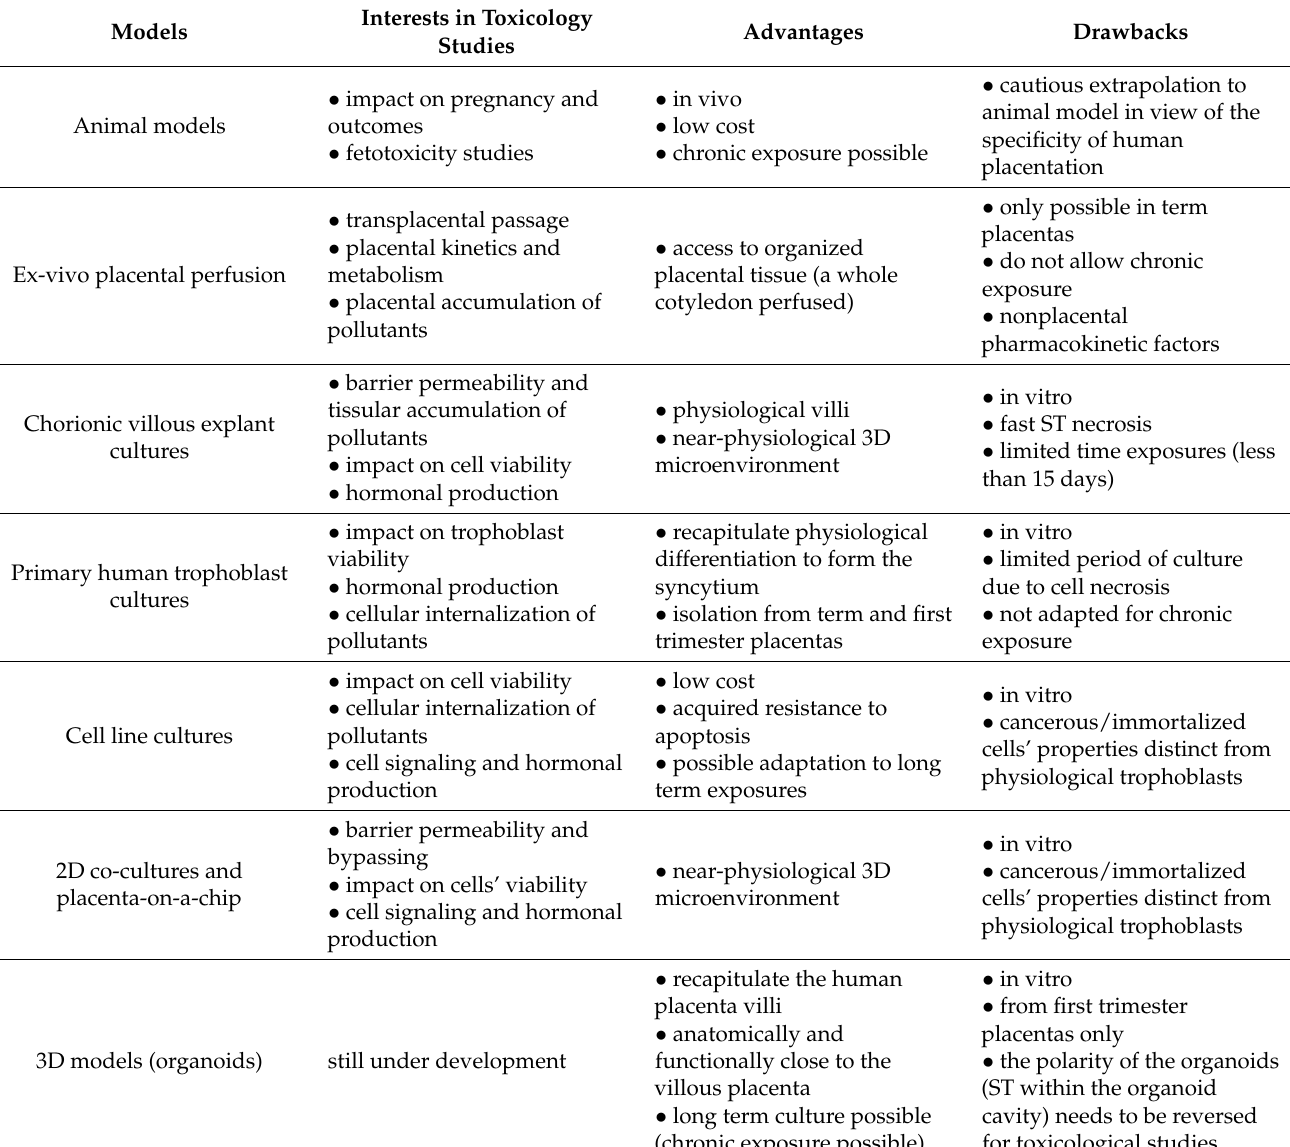
Table 1. Summary of the different models to study toxic effects on the human placental